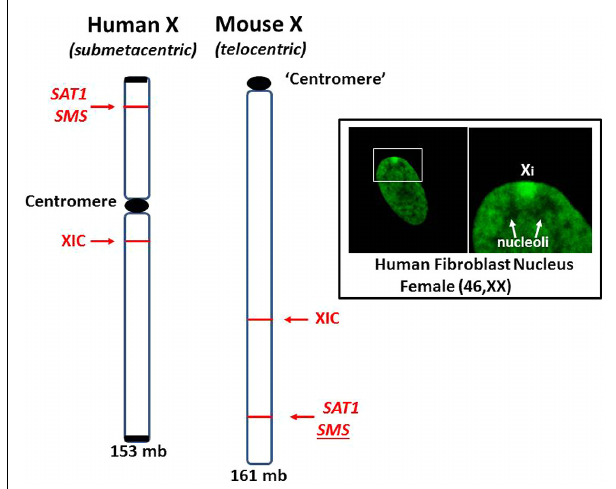
FIGURE 6 | Comparison of human and mouse X chromosomes. The human X (153 mb) and the mouse X (161 mb) are ∼ 95% similar in gene content but are significantly different in the arrangement of genes and overall structure (Boyd etal., 2000).The human X is submetacentric with a centromere separating its arms.The mouse X is telocentric with only one arm and a centromere-like structure at one end. X inactivation can spread unencumbered on the mouse X since there is no centromere or L1 gradient to negotiate. For example, the SAT1 and SMS genes are on the other side of the centromere from the XIC in the human X but no such barrier exists in the mouse X. Inset: Human fibroblast stained with fluorescein-tagged anti-histone H1.2 antibodies highlights the inactive X chromosome (Xi), showing its dense heterochromatic character, perinuclear location and its proximity to nucleoli.This places one of the most inactive structures, Xi, close to one of the most dynamic and multi-functional structures, the